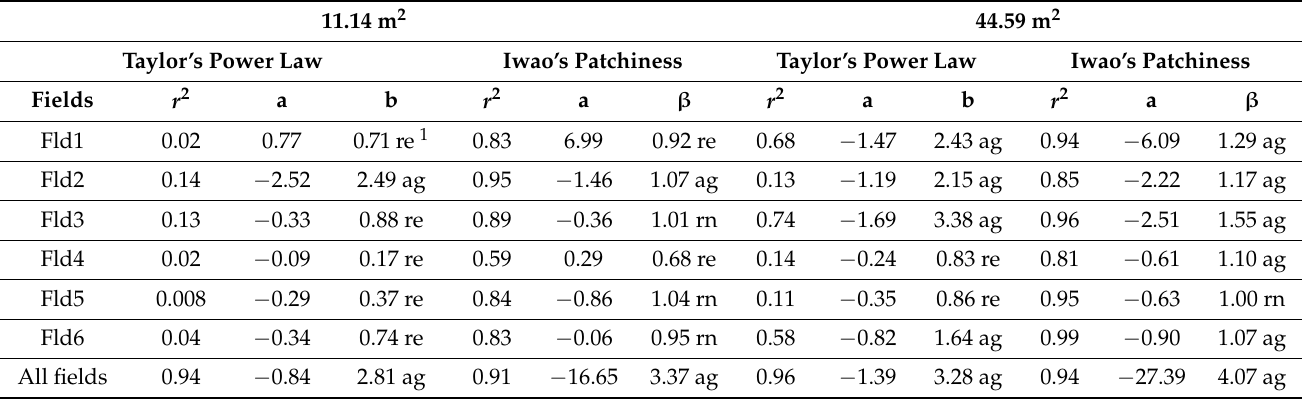
Table 5. Distribution pattern of melon thrips in small and large bean plots using flower samples.